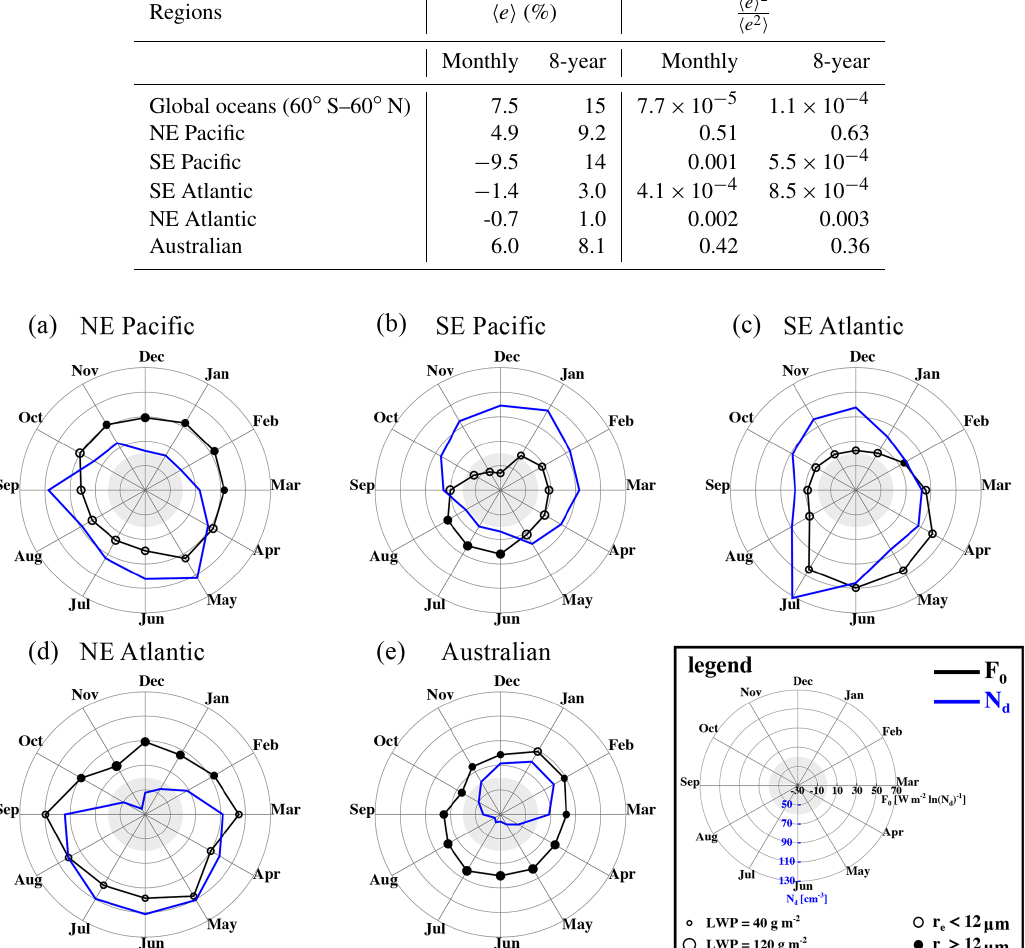
Figure 9. Same as in Fig. 7 left column and overlaid with monthly mean N d in